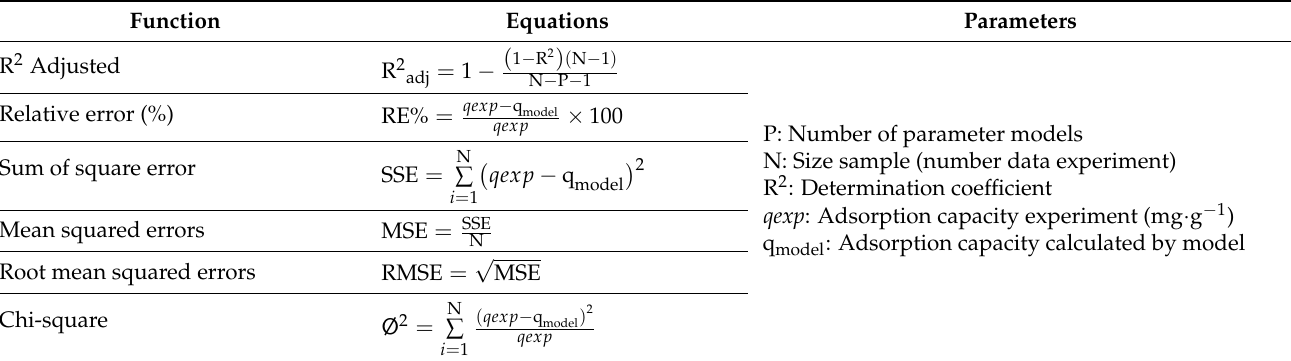
Table A1. Error function equations used to evaluate the best fit of kinetic and isothermal models.